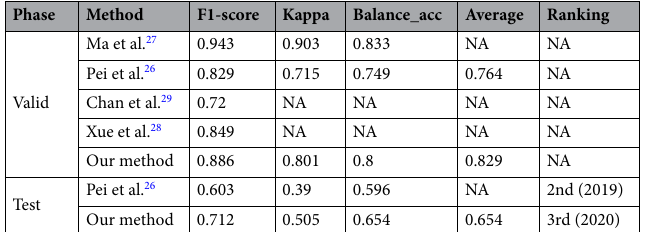
Table 2. Performance comparison among state-of-the-art approaches in CPM-RadPath 2019/2020. All references are coming from the top teams in the CPM-RadPath